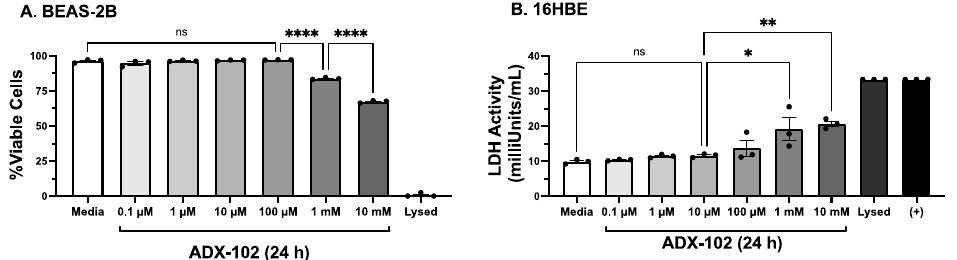
Figure 1. ADX-102 and bronchial epithelial cell viability. Medium release of lactate dehydrogenase (LDH) was measured and expressed as % viability in BEAS-2B cells ( A ) or LDH activity in 16HBE cells ( B ) after 24 h treatment with 0.1 µM to 10 mM ADX-102 in M-199 with 10% serum (Media). An equal number of cells were sonicated for maximum LDH release (Lysed). Positive assay control (+) was provided by a manufacturer. * p < 0.05 and ** p < 0.01 vs. 10 µM ADX-102; **** p < 0.0001 vs. 0– 100 µM ADX-102. Bars represent SEM of biological n of three with three technical replicates. ns = not significant.